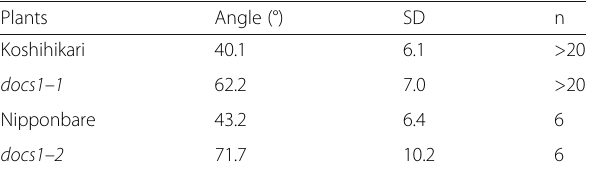
Table 1 Root cone angle measures in WT and mutant plants grown in rhizoboxes